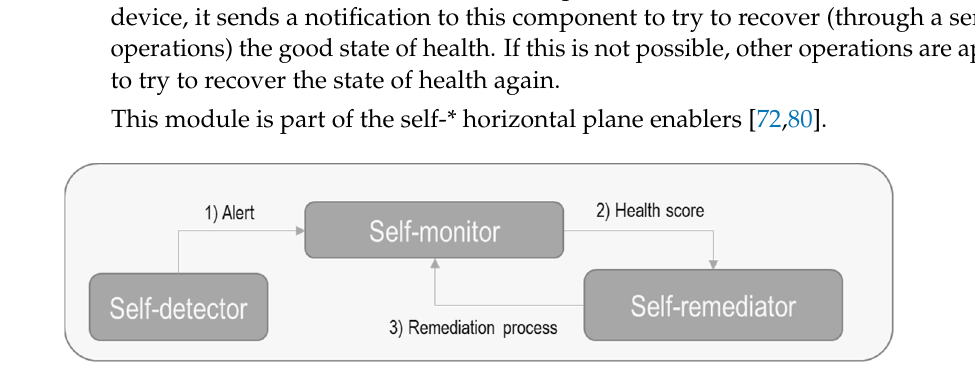
Figure 7. Self-healing structure, as proposed by ASSIST-IoT. Source: the authors’ own diagram, based on [73]. on